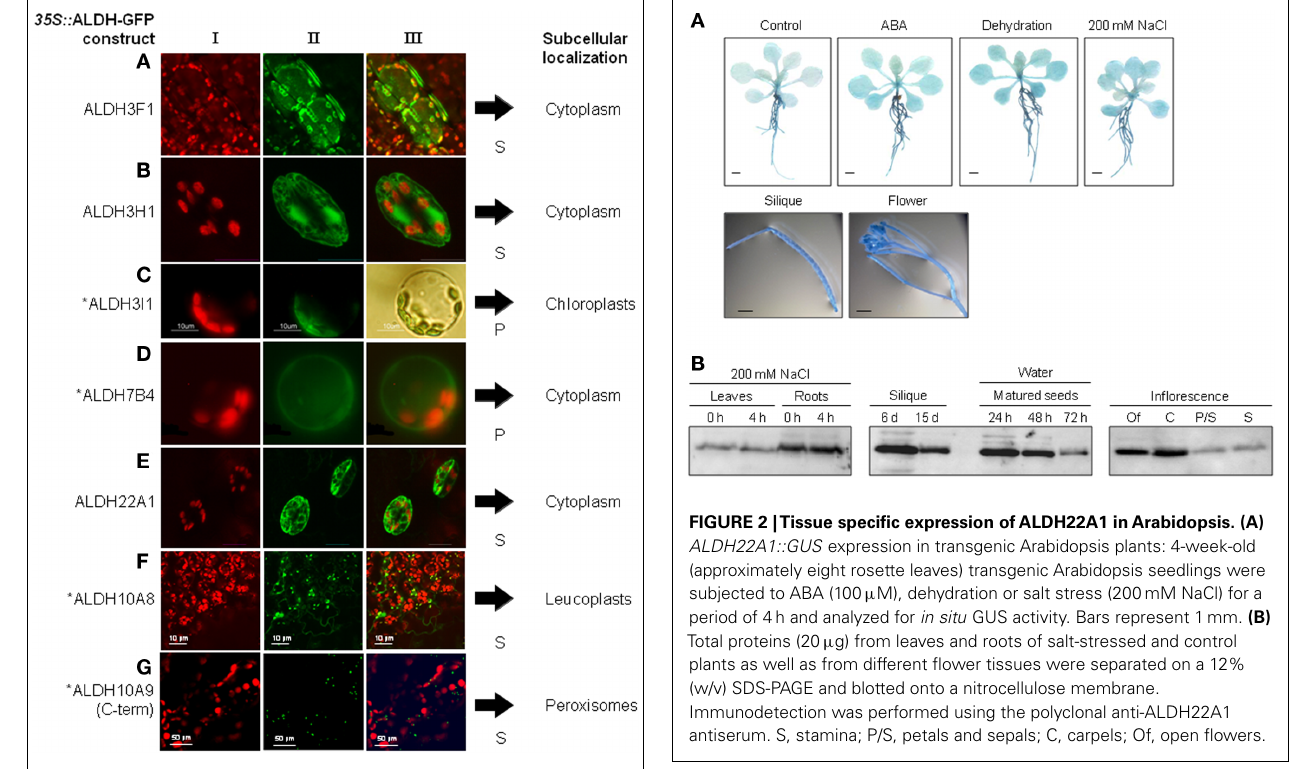
FIGURE 1 | Overview of subcellular localizations ofArabidopsis ALDH-GFP fusion proteins. 35S ::ALDH-GFP fusion proteins were expressed in Arabidopsis and viewed under fluorescence light with appropriate filters. (I) shows chlorophyll auto-fluorescence, (II) the GFP-signal, and (III) the merged signals. For ALDH3I1 the transformed protoplast in (C) is shown in bright field to visualize the chloroplasts. S, stable expression after Agrobacterium-mediated transformation; P, transient expression in protoplasts. * GFP-data for ALDH3I1, ALDH7B4, ALDH10A8, and ALDH10A9 have been published (Kotchoni et al., 2006; Missihoun et al., 2011). (A) gene ALDH3F1, (B) gene ALDH3H1, (C) gene ALDH3I1, (D) ALDH7B4, (E) ALDH22A1, (F) ALDH10A8, (G) ALDH10A9.